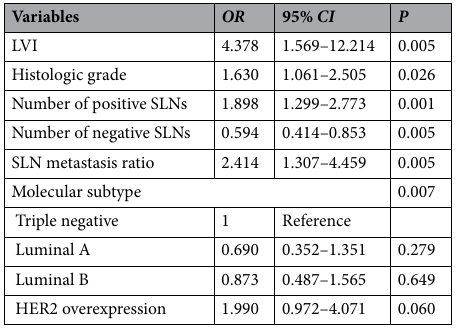
Table 3. Multivariate analysis of variables associated with NSLN metastasis.